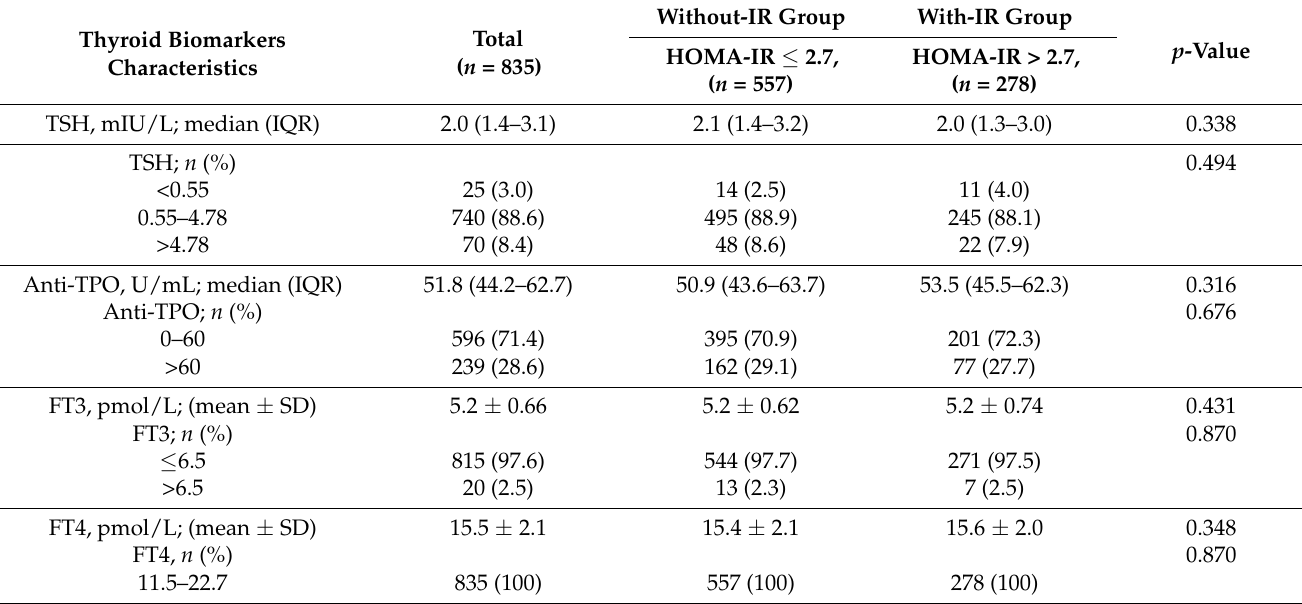
Table 4. The thyroid biomarker characteristics of subject groups without and with